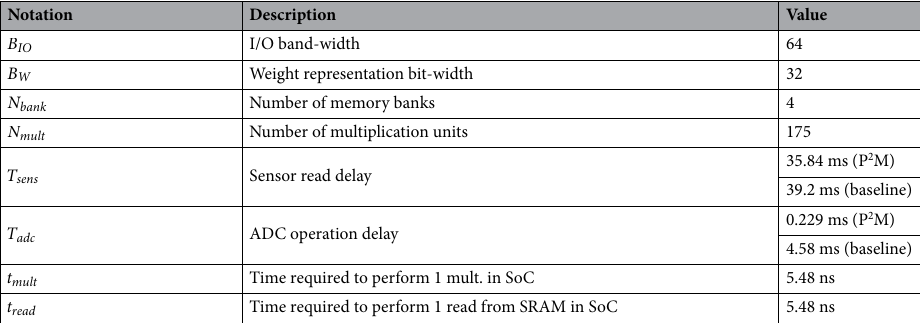
Table 6. The description and values of the notations used for computation of delay. Note that we calculated the delay in 22 nm technology for 32-bit read and MAdd operations by applying standard technology scaling rules initial values in 65 nm technology 48 . We directly evaluated the T read and T adc through circuit simulations in 22 nm technology node.